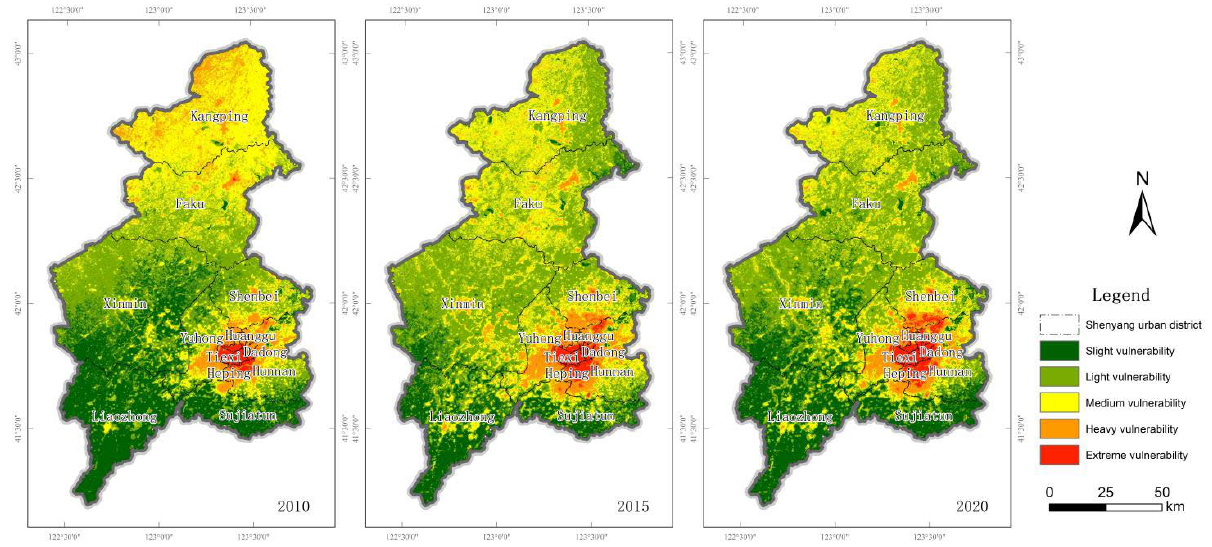
Figure 3. Spatial classification of ecological vulnerability in Shenyang in 2010, 2015 and 2020.